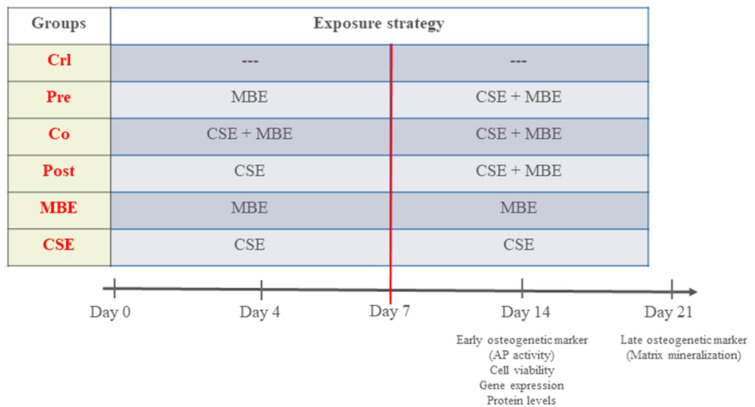
The experimental set-up in the studyMBE= Maqui berry extract; CSE= Cigarette smoke extract